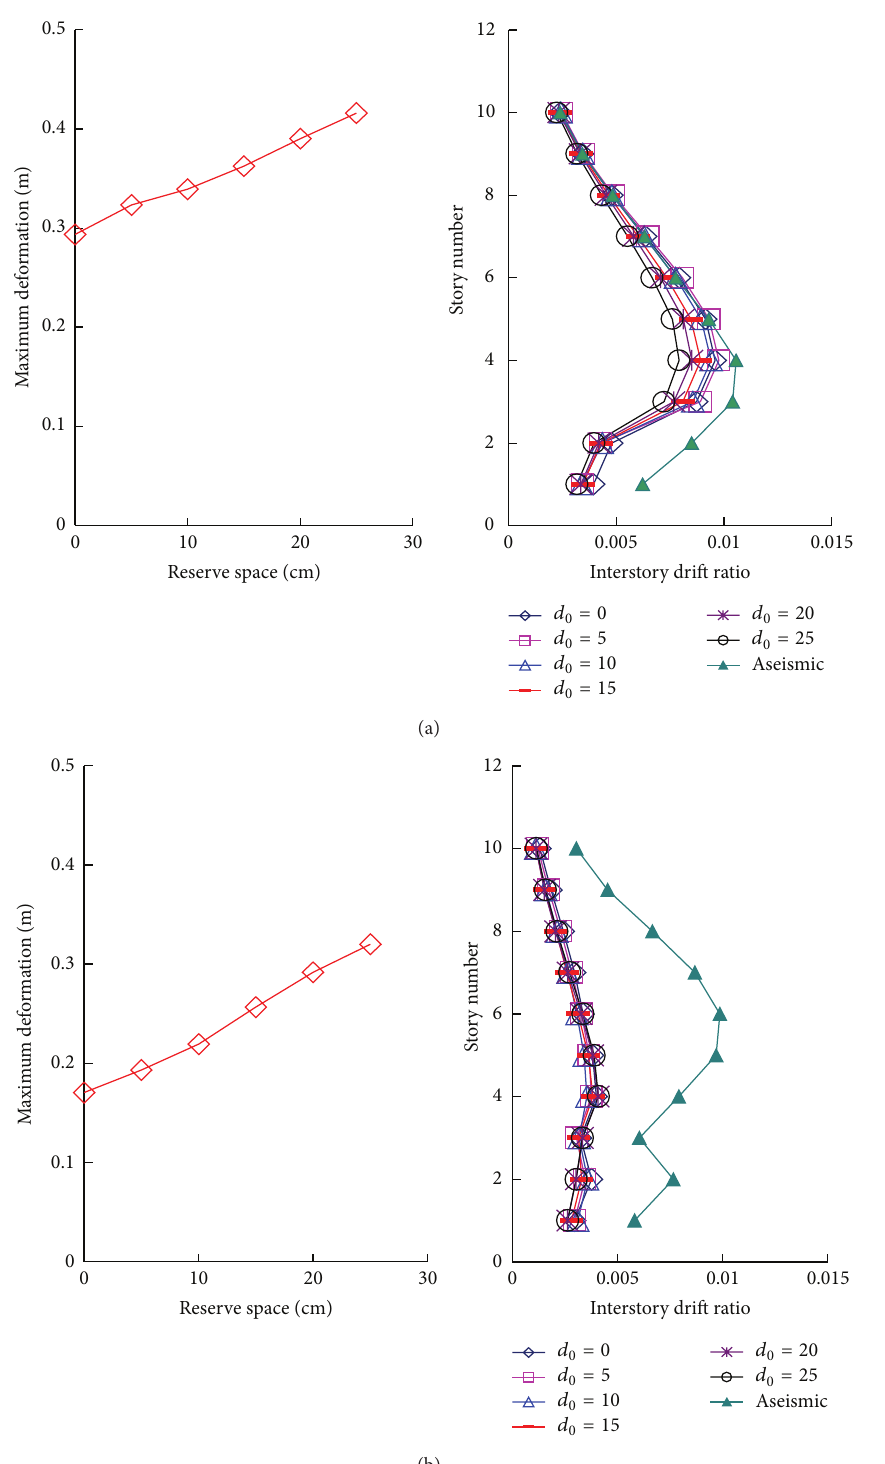
Figure 13: Effect of reserve spaces on response of midstory isolated structure under different earthquake waves. (a) HE04230; (b)